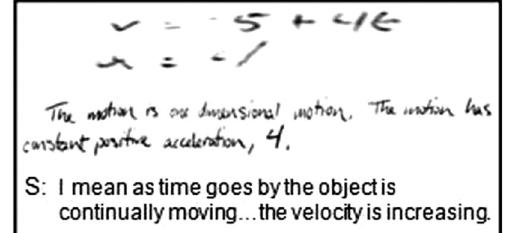
FIG. 8. Interpretation of position equation (question 1).